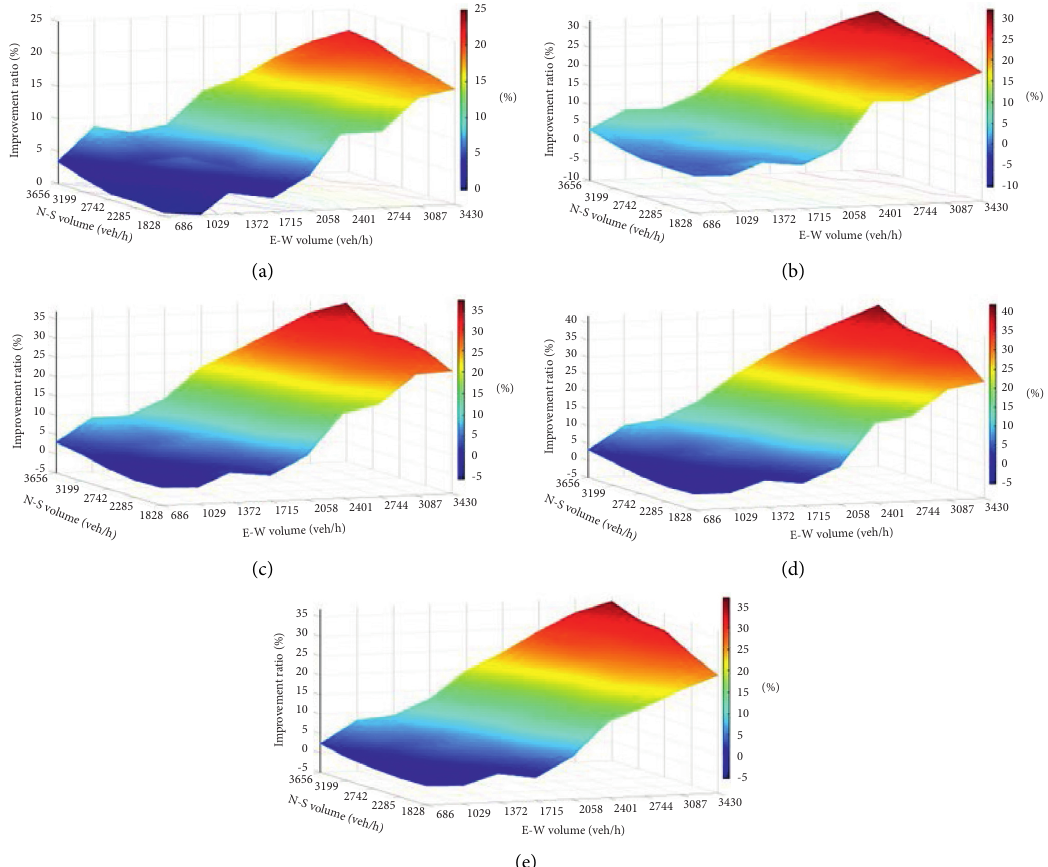
Figure 9: Improvement ratios of capacity. (a) Scheme 1. (b) Scheme 2. (c) Scheme 3. (d) Scheme 4. (e) Scheme 5. E-W volume means the same traffic volume of east entrance and west entrance. N-S volume means the same traffic volume of north entrance and south